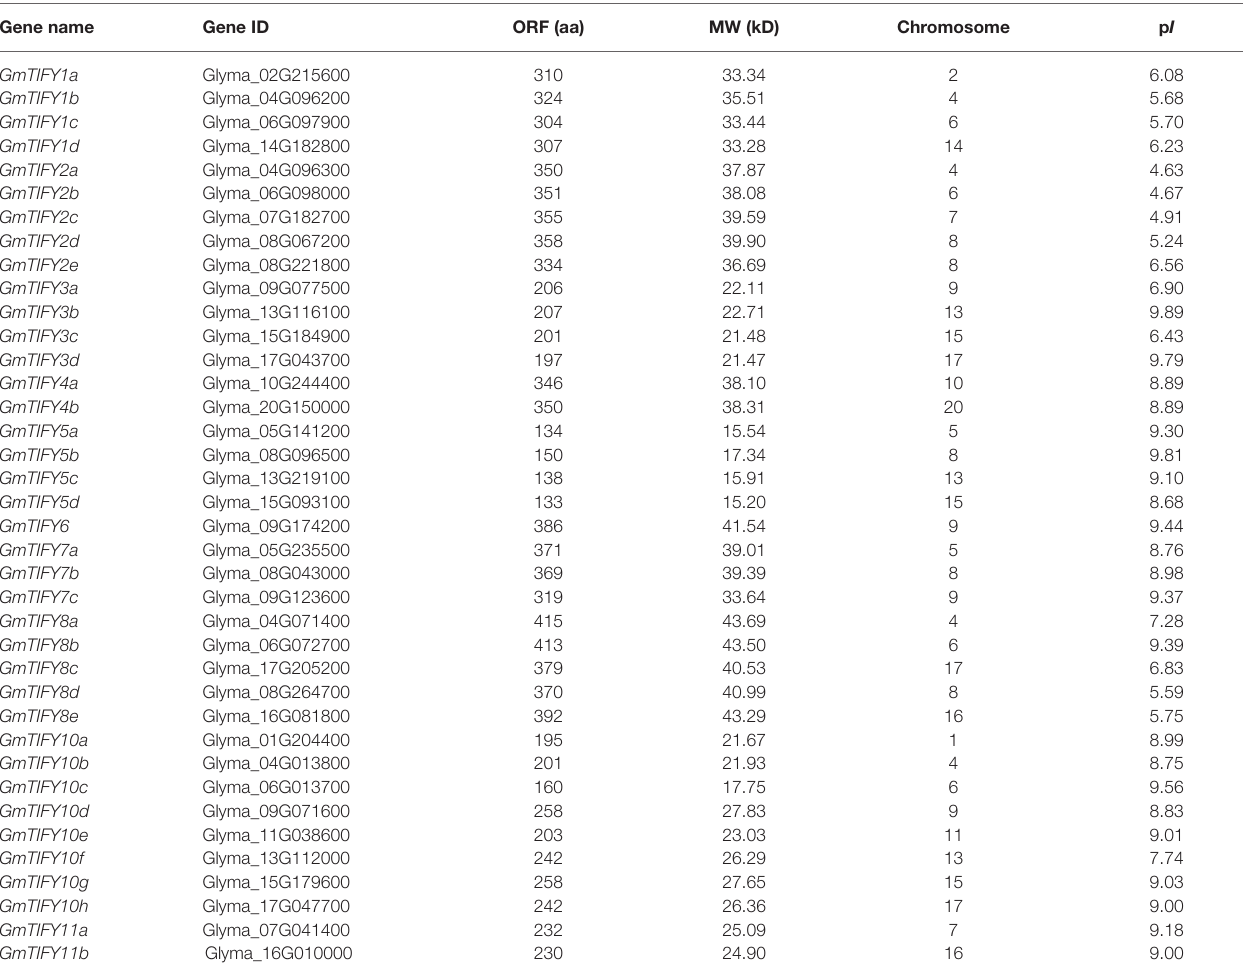
TABLE 1 | Details of the 38 soybean TIFY